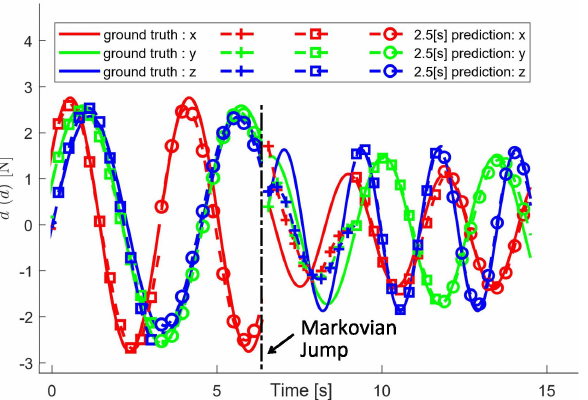
Figure 4. Disturbance prediction example by MDA–net. Solid curves showing ground truth; marked curves showing 2.5 (s) prediction from three different instants.